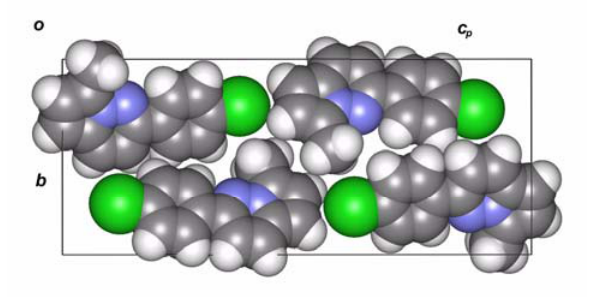
Figure 2. [100] projection of the crystal structure of